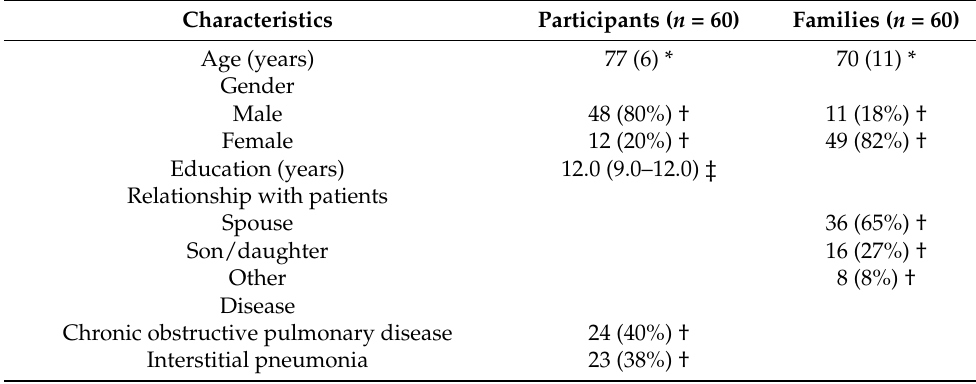
Table 3. Characteristics of the participants and their family